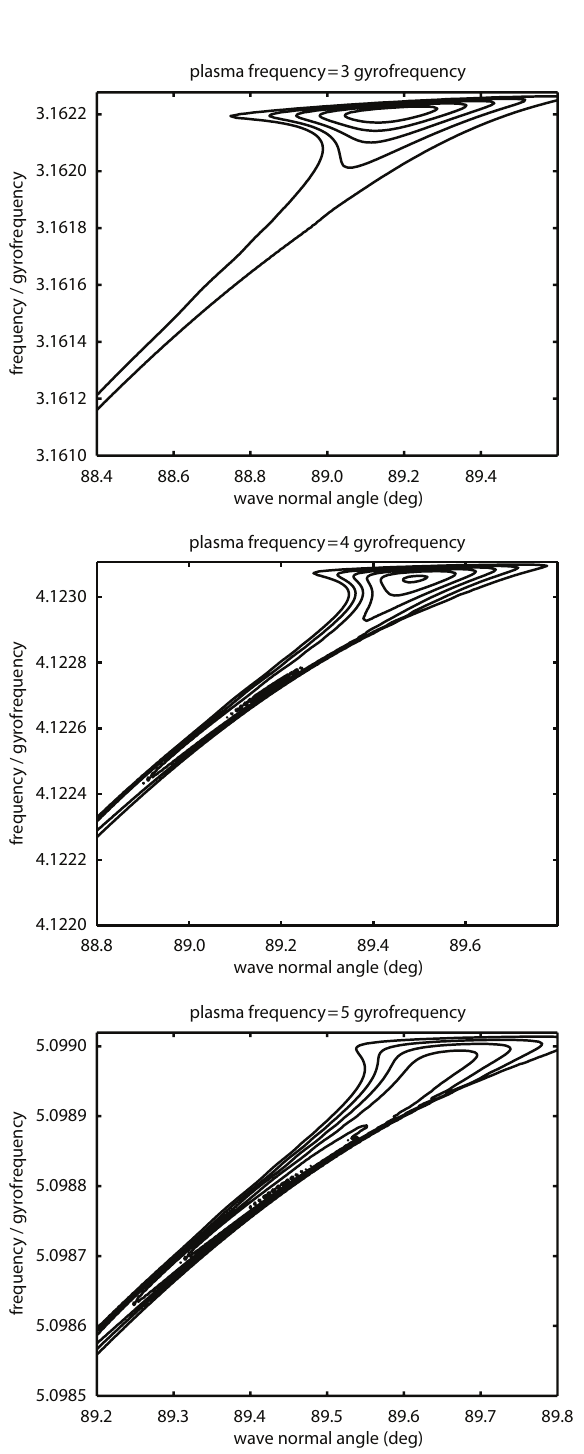
Fig. 6. Contours of the Z-mode temporal growth rate (relative to the cyclotron frequency) versus wave normal angle for three different cases of ω p / (cid:127) =3, 4, and 5. The peak growth rates for each panel are (top) 1.5 × 10 − 4 , (middle) 2.2 × 10 − 4 , and (bottom) 7.2 × 10 − 4 .